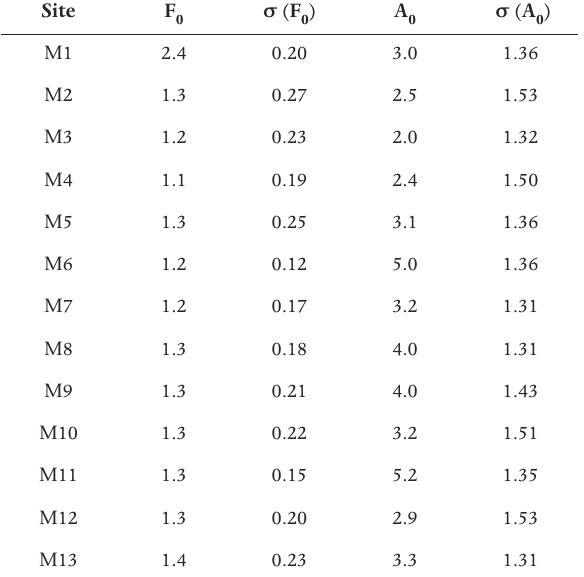
) and corresponding amplitude (A 0